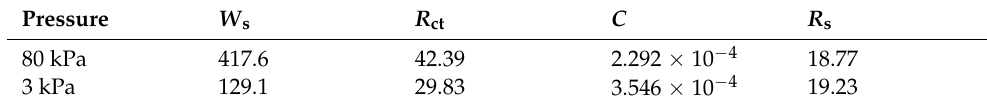
Table 1. Fitting data of CIGS thin films deposition impedance at 3 kPa ( Ω ).